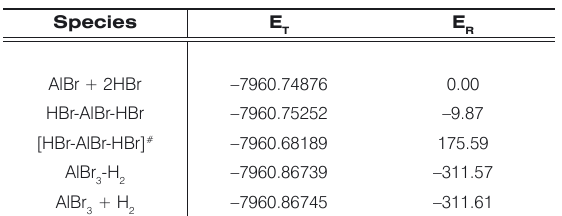
Table 3. CCSD(T)/6-311G(d,p)//B3LYP/6-311G(d,p) + ZPE Total (a.u.) and Relative Energies ER (kJ mol -1 ) for Energies E T the reaction AlCl+HCl (reaction channel (1)).